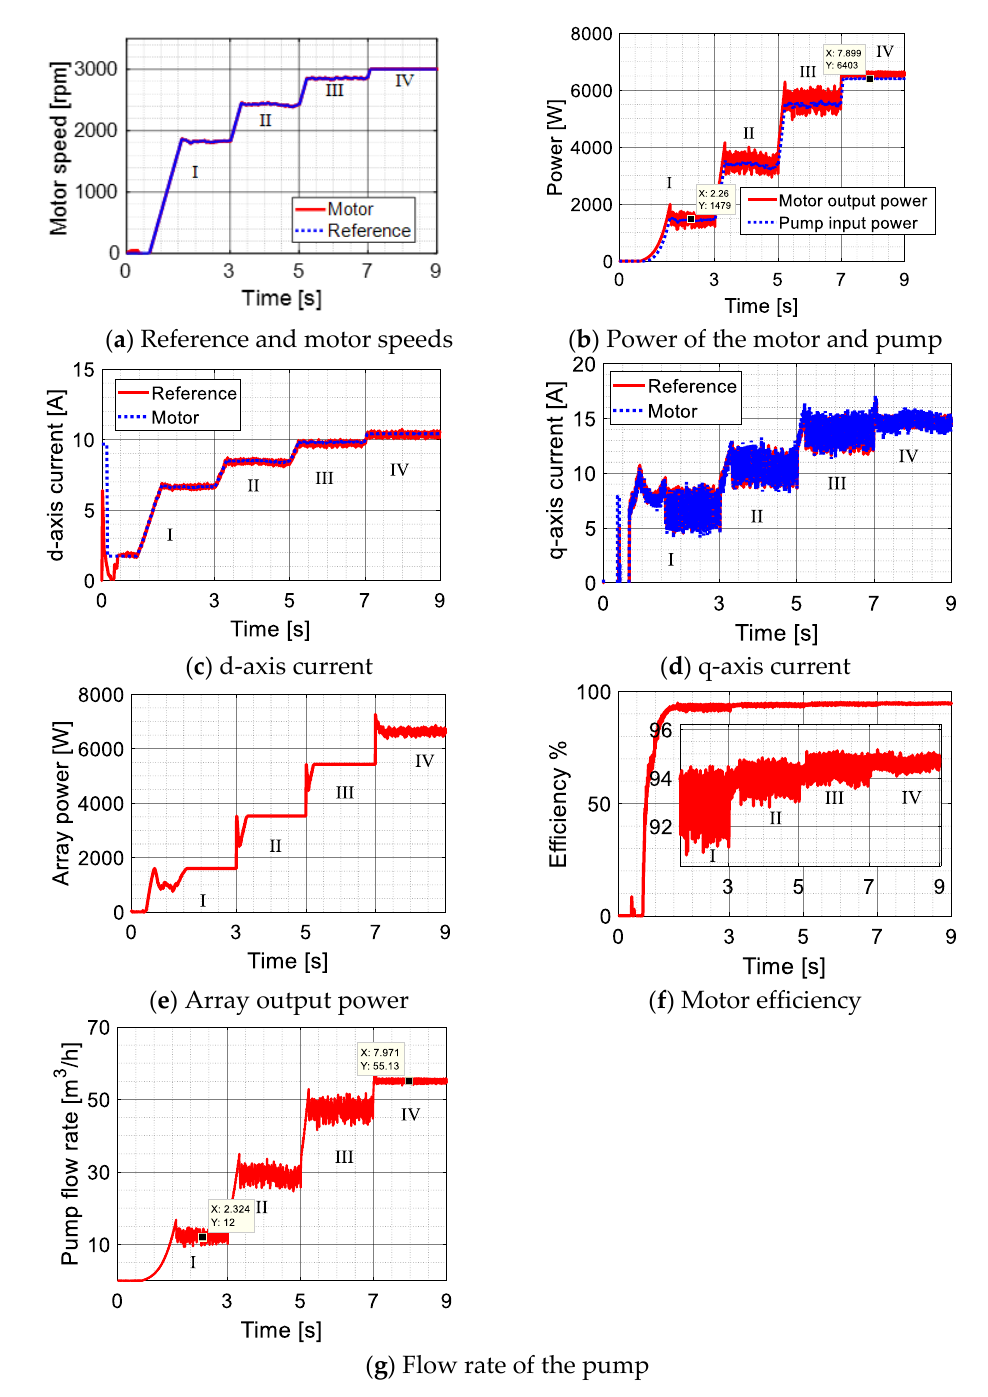
Figure 10. Performance of the anticipated PVWPS at ambient temperature of 30 °C and various solar irradiation levels (I = 0.25 kW/m 2 , II = 0.5 kW/m 2 , III = 0.75 kW/m 2 and IV = 1 kW/m 2 ).